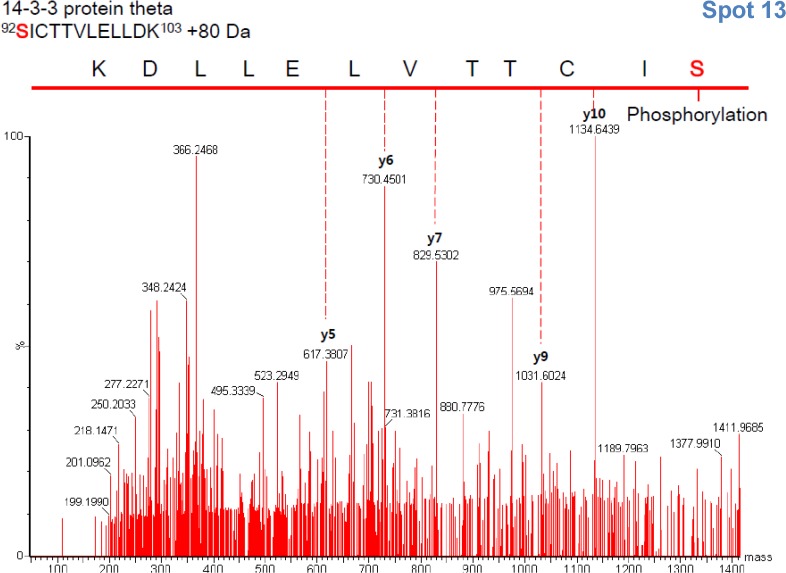
MS/MS Spectrum of 14–3–3θ peptide phosphorylated at Ser92 (92SICTTVLELLDK103 of spot No. 13).